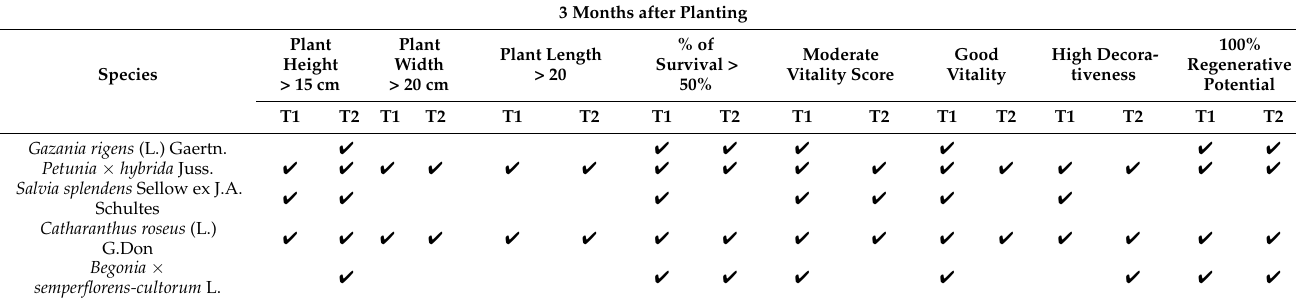
Table 6. Adaptability assessment of 5 different flowering species to water stress based on the qualitative and quantitative characteristics for a period of three months after